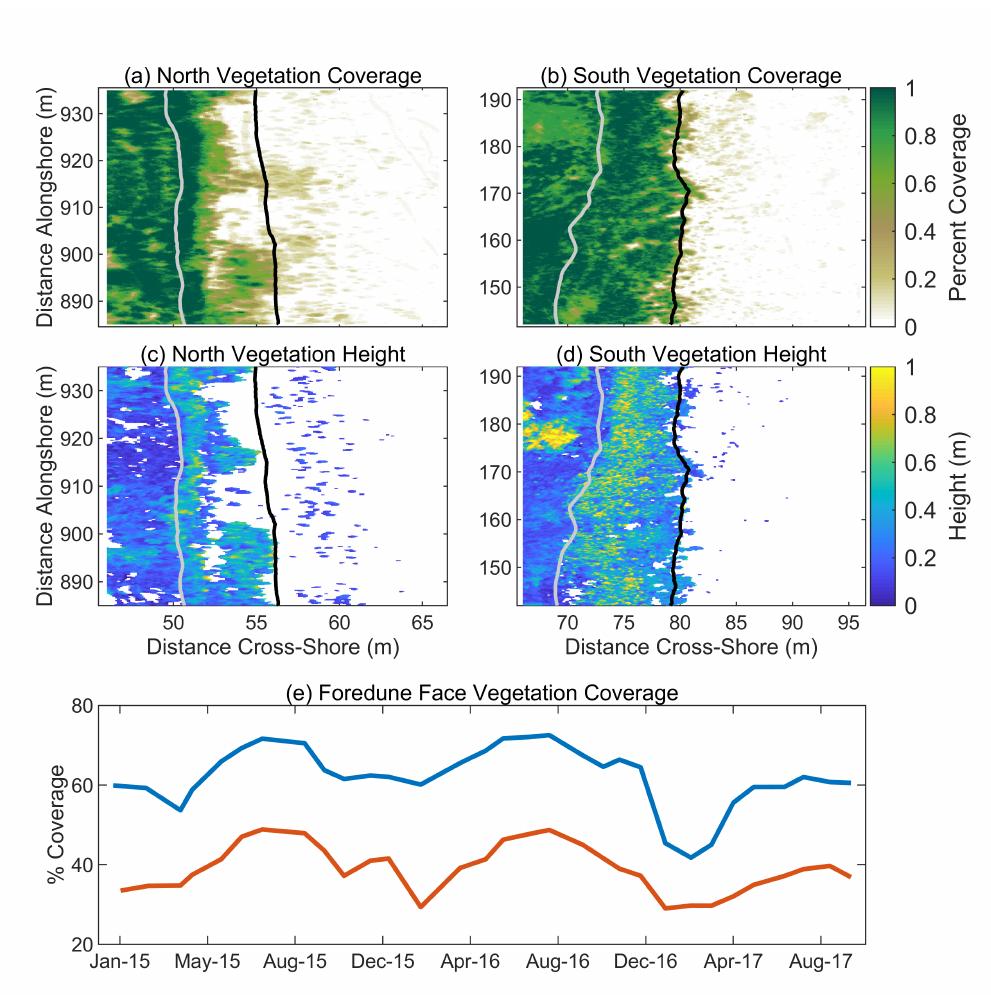
Figure 9. Vegetation characteristics for both sites over the course of the study. ( a , b ) Percent vegetation coverage through time (colors top right) and ( c , d ) example summer (11 August 2016) vegetation height (m, colors bottom right) at each cross-shore (x) and alongshore (y) grid cell at the north and south sites, respectively. The time-averaged location of z c and z t are shown in the gray and black line, respectively. ( e ) Percent coverage of vegetation on the foredune face during each survey for the north (red) and south (blue)